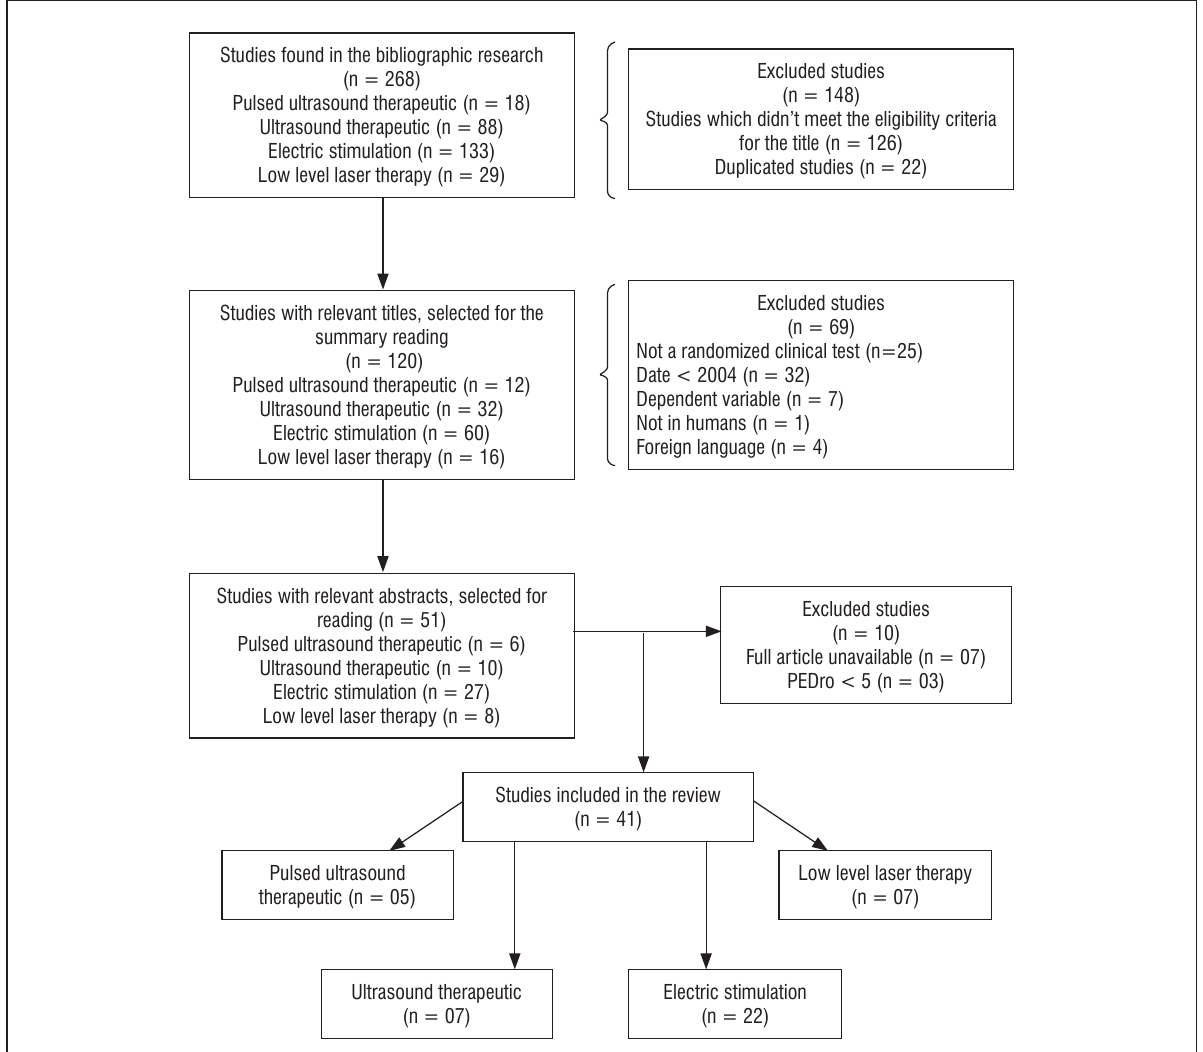
Figure 1 - Study selection results for